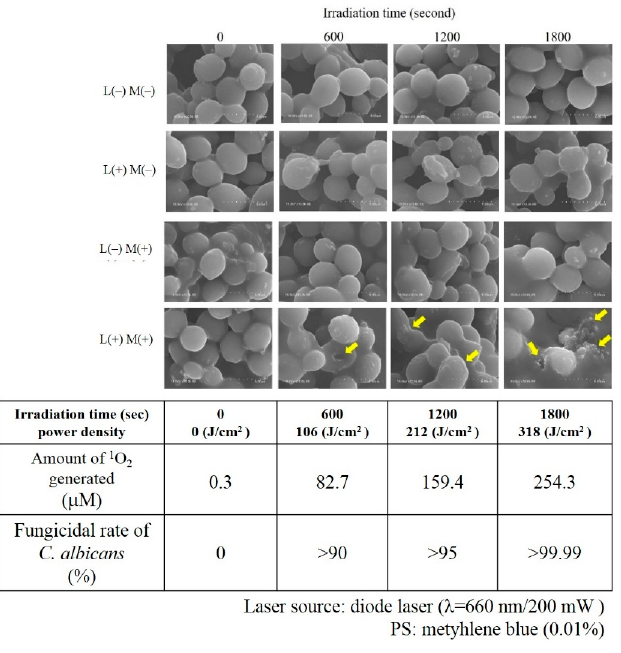
Figure 6. Morphological evaluation of Candida albicans during 1 O 2 exposure in scanning electron microscopy. A previous report designated C. albicans as follows: with diode laser irradiation: L(+); without diode laser irradiation: L(–); with MB: M(+); without MB: M(–). These were combined to form four groups: L(+)M(+); L(+)M(–); L(–)M(+); and L(–)M(–). Only L(+)M(+) showed changes in C. albicans morphology. The yellow arrows indicate that the morphology of C. albicans was damaged